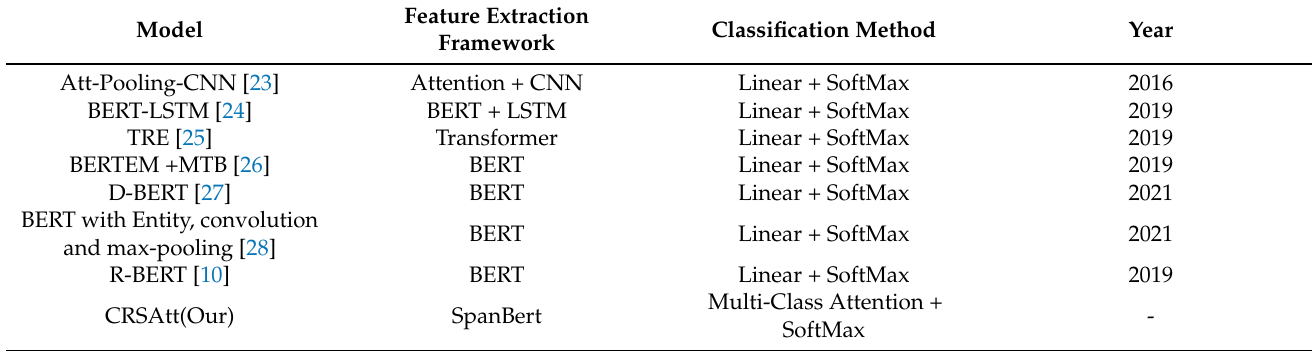
Table 3. Summary of our model and the attention-based mechanism